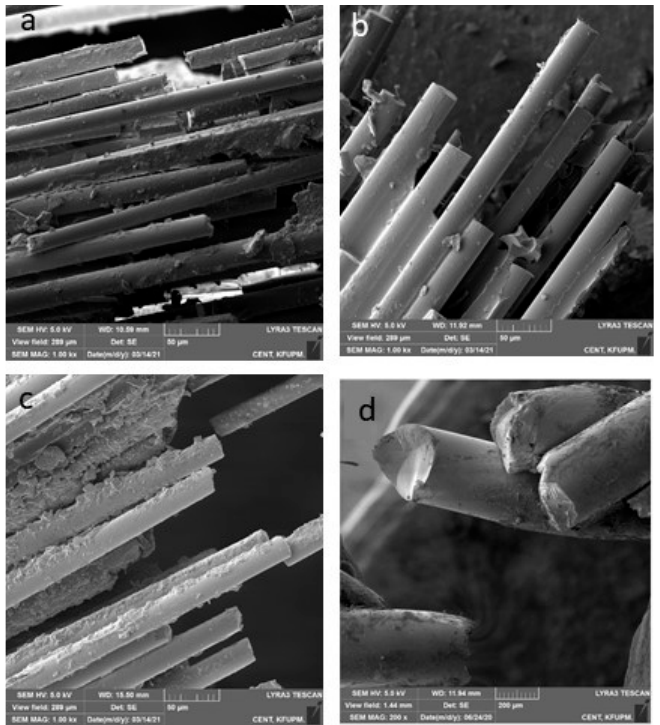
Figure 6. Representative scanning electron microscopic images of ( a ) nHA/EG, ( b ) EG, ( c ) EST, and ( d ) SS retainers after static loading showing the fractured parts of the retainers. Table 2. Frequencies (%) of failure types of experimental and control orthodontic retainers after debonding.